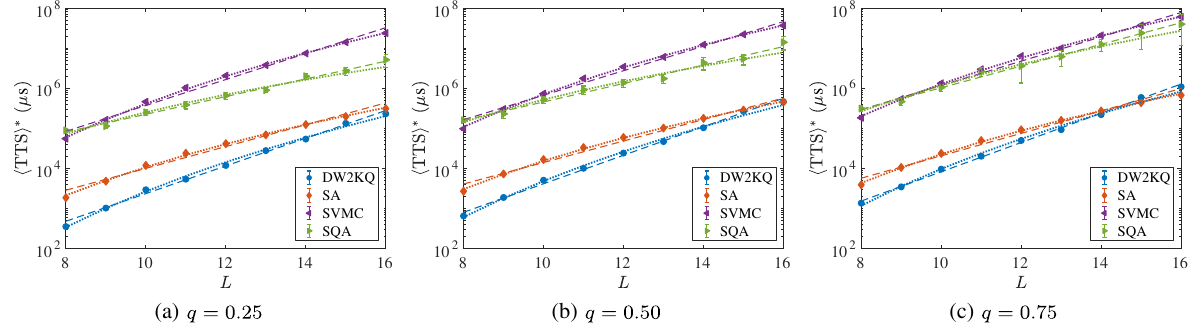
FIG. 17. Scaling of the optimal TTS with problem size for hardware-planted instances. The data points represent the DW2KQ (blue circles) and three classical solvers, SA (red diamonds), SVMC (purple left triangle), and SQA (green right triangle). The dashed and dotted curves correspond, respectively, to exponential and polynomial best fits with parameters given in Table II. Panels (a) – (c) correspond to the 25th quantile, median, and 75th quantile, respectively. Simulation parameters for SA, SVMC, and SQA are given in Appendix C. The data symbols obscure the error bars, representing the 95% confidence interval for each optimal TTS data point (computed from the fit of ln h TTS i to a quadratic function as explained in Appendix